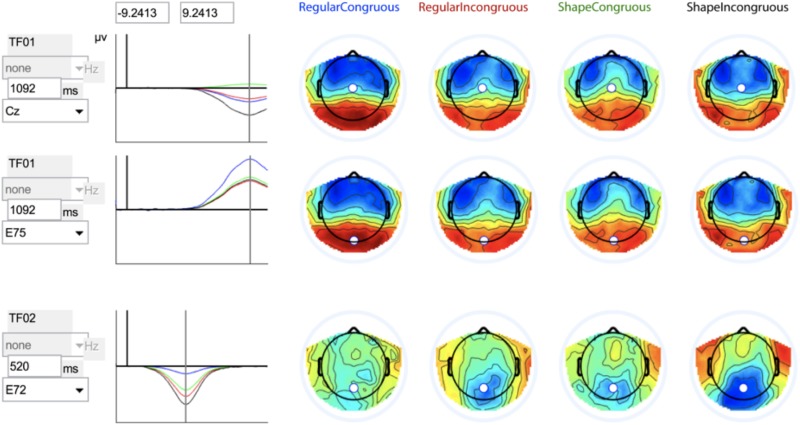
Illustration of the two temporal factors (TF01 and TF02) from the PCA analysis. The figure includes topographical plots of the components in each of the four conditions (regular object vs. shape, and congruous vs. incongruous presentations), where the color blue represents a negative amplitude, and red represents a positive amplitude. The graphs show the temporal properties of the components in each of the four conditions (negative amplitude plotted downward). Electrodes showing the largest effect of incongruity were chosen to illustrate the component waveforms, and for TF01 the topography of this effect differed in the regular object and shape conditions, which is why we display both a central electrode (Cz) for the shape incongruity effect, and parietal/occipital electrode (E75) for the regular incongruity effect.